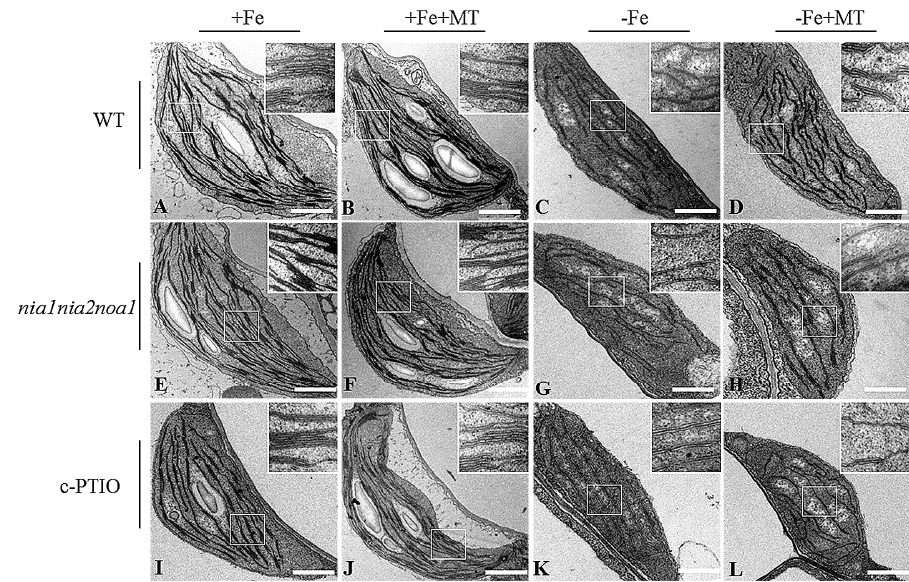
Figure 8. The effect of exogenous melatonin on chloroplast ultrastructure in the WT ( A – D ), nia1nia2noa1 ( E – H ), and c-PTIO-treated ( I – L ) Arabidopsis plants. Seven-day-old seedlings were treated with or without 5 μ M melatonin in the presence or absence of 50 μ M Fe for 8 days. Then the leaves from these plants were sampled for transmission electron micrographic analyses of the chloroplast ultrastructure: ( A , E , I ), +Fe; ( B , F , J ), +Fe + MT; ( C , G , K ), − Fe; ( D , H , L ), − Fe + MT; Scale bar = 1 μ m.